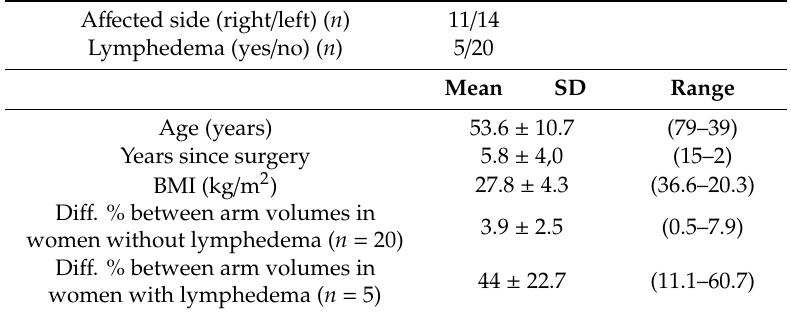
Table 1. Characteristics of the participants.